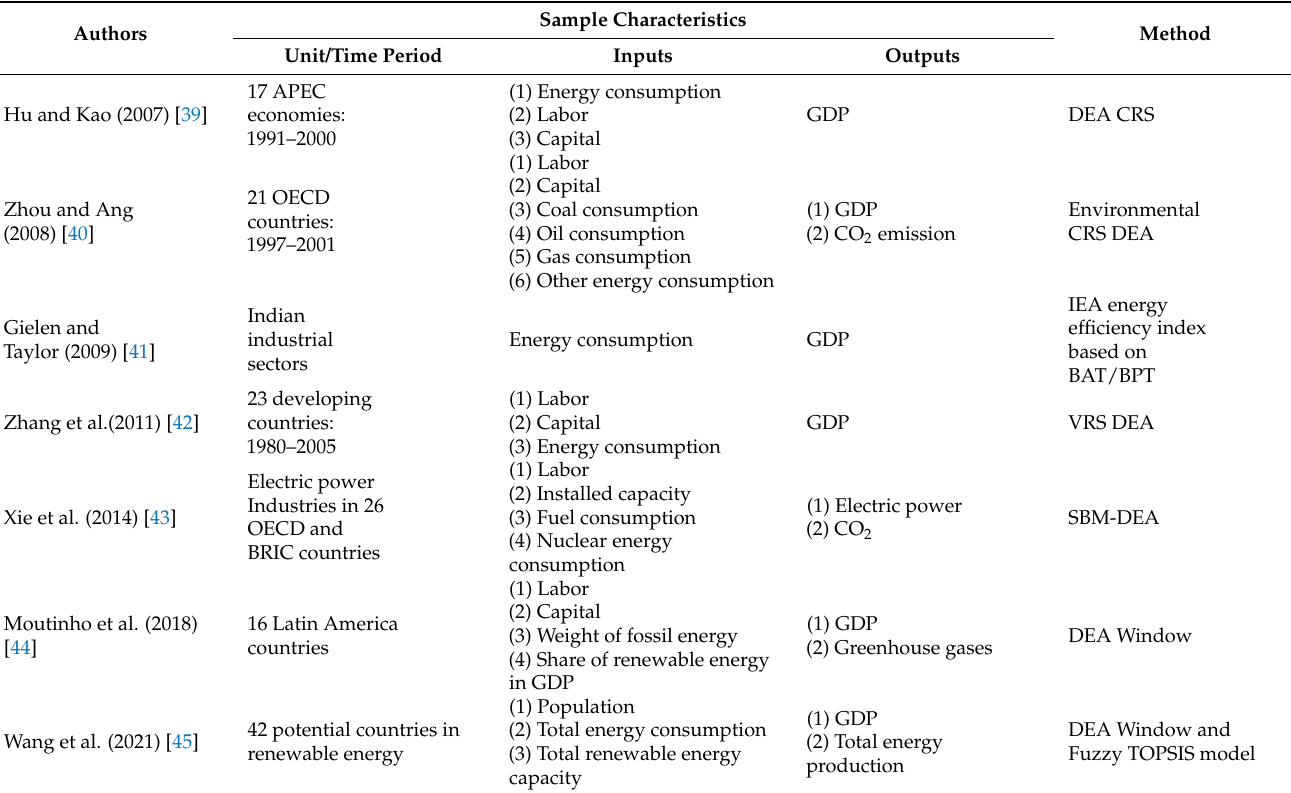
Table A1. List of common inputs/outputs for evaluating environmental efficiency by Data Envelopment Analysis (DEA)